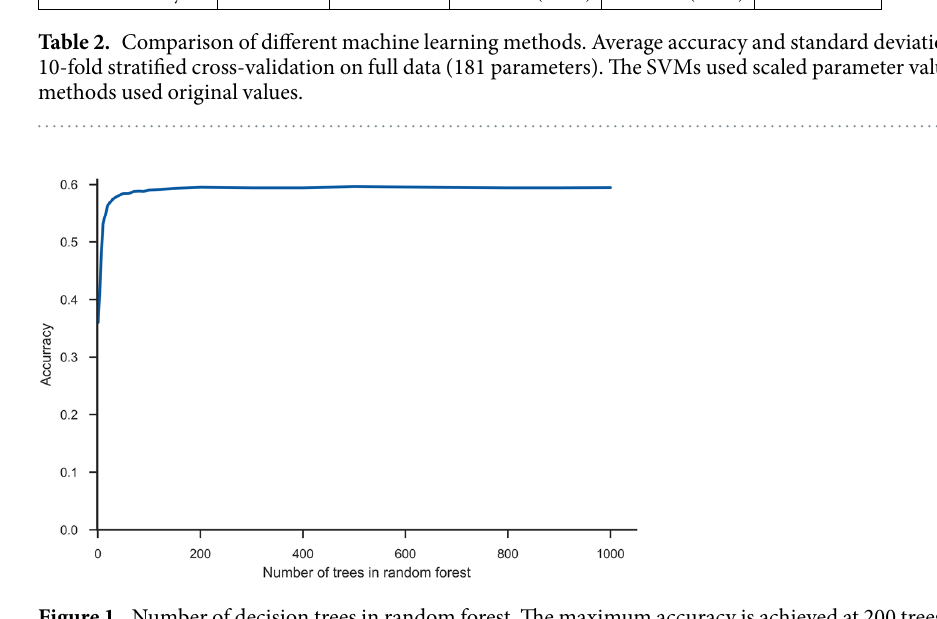
Figure 1. Number of decision trees in random forest. The maximum accuracy is achieved at 200 trees. Further increasing the number of trees increases the training and execution time without significant accuracy benefits, however it slightly reduces the